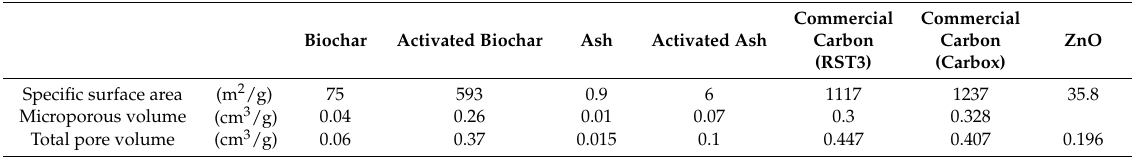
Table 2. Surface and volume characteristics for the materials tested.